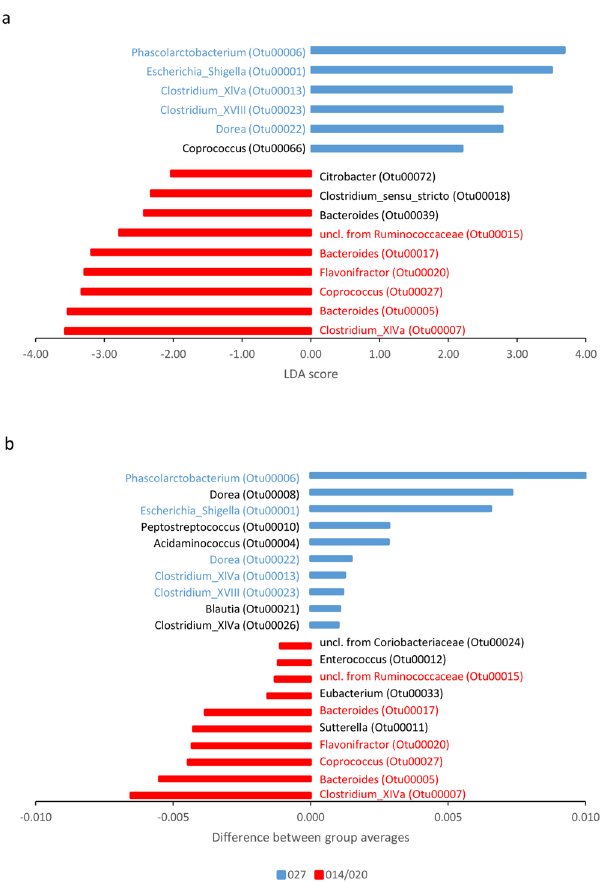
Figure 4. OTUs associated with WCAB (Wilkins Chalgren Anaerobe Broth) conditioned medium of ribotype 027 ( ) or ribotype 014/020 ( ), on day 5, selected by using ( a ) the mothur software (LEfSe test) and ( b ) machine learning (PCT, CLUS software). Blue font marks OTUs increased in ribotype 027 conditioned medium, red font marks OTUs increased in ribotype 014/020 conditioned medium, detected with both data analysis approaches, respectively. For the mothur analysis, only the LDA scores of significant OTUs are shown. For the machine learning analysis, the values represent the difference of OTU relative abundances between the left and right branch of the segment C in the PCT (shown in Fig.